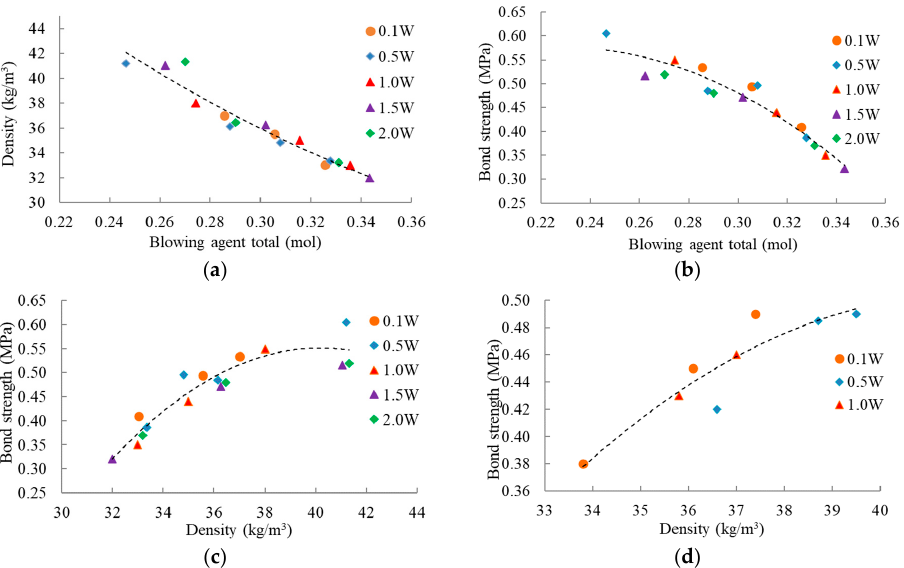
Figure 2. Relationships among total content of blowing agent, density, and bond strength. ( a ) Density of PUR foam vs. total content of blowing agents. ( b ) Tensile bond strength of PUR foam vs. total content of blowing agents. ( c ) Tensile bond strength of PUR foam vs. foam density. ( d ) Tensile bond strength of PUR foam after cryoshock test vs. foam density (water content in pbw in compositions in fi gure’s legend as: 0.1… 2.0 W).